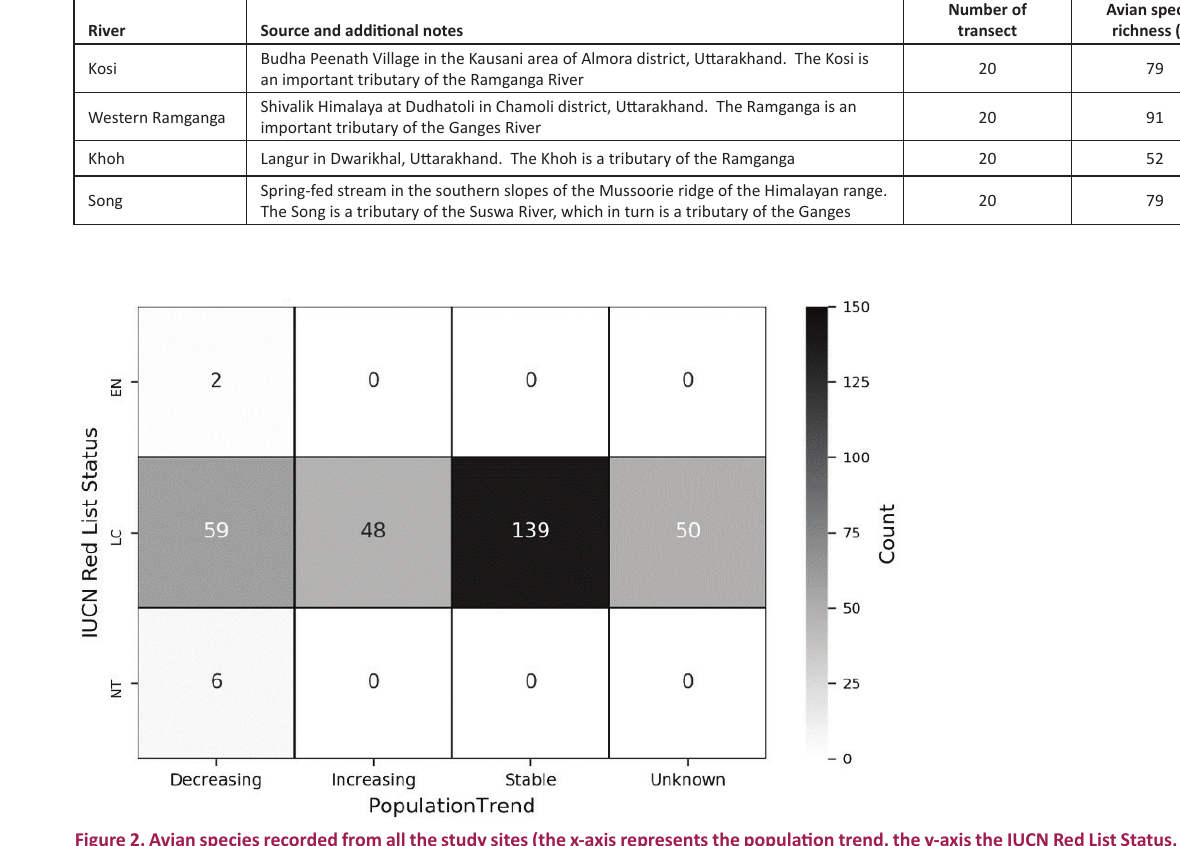
Figure 2. Avian species recorded from all the study sites (the x-axis represents the population trend, the y-axis the IUCN Red List Status, and the bars provide the IUCN Red List Status and their corresponding population